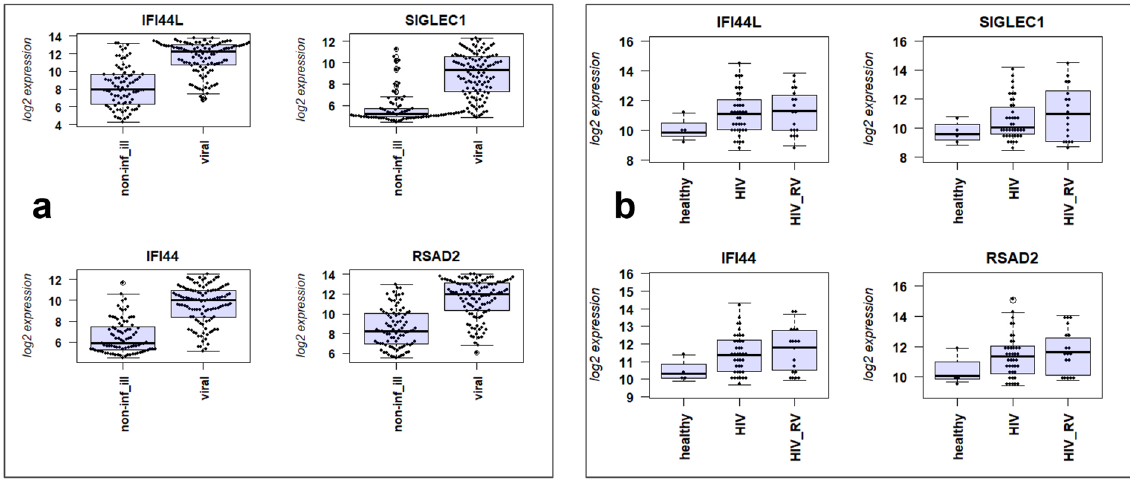
Figure 2. Comparison of expression levels of top regulated genes from non-HIV cohort. Boxplot of individual gene expression levels as normalized log 2 expression values. The top four genes up-regulated in the non-HIV cohort are shown for the non HIV-cohort in ( a ) and for the PWH cohort in ( b ). All pairwise differences in ( a ) are statistically significant ( p < 0.01); all differences in ( b ) are not significantly different. For non-HIV cohort: non-inf-ill: control group in non-HIV infected patients who had lung conditions but no infections, viral: patients infected with respiratory virus in non-HIV cohort. For PWH cohort: healthy: healthy controls; HIV: non-infected PWH; HIV_RV: PWH infected with respiratory virus. Gene name abbreviations: Interferon Induced Protein 44 Like ( IFI44L ), Sialic Acid Binding Ig Like Lectin 1 ( SIGLEC1 ), Interferon Induced Protein 44 ( IFI44 ), Radical S-Adenosyl Methionine Domain Containing 2 ( RSAD2 functions of neurotensin, e.g. hypotension, hyperglycemia, hypothermia, antinociception, and intestinal motil- ity and secretion 16 . Maestro Heat Like Repeat Family Member 5 ( MROH5 ) does not have any known biological functions. Cyclin A1 ( CCNA1 ) encodes a protein of the cyclin family. It functions as regulator of CDK kinases characterized by a periodicity in the cell cycle. It binds to other cell cycle regulators, such as retinoblastoma (Rb) family proteins, transcription factor E2F-1, and the p21 family proteins 16 .